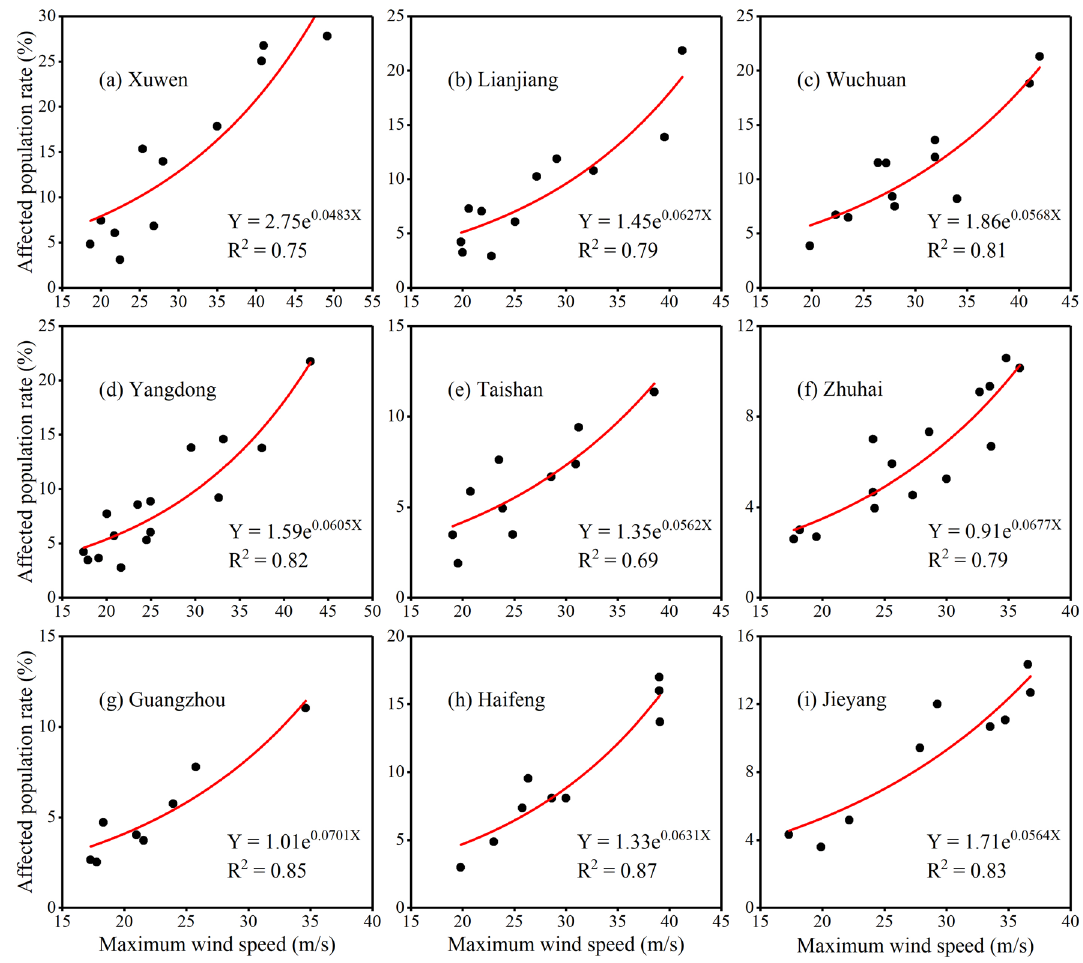
Fig. 3 Loss rates for the affected population fitted with maximum wind speed (MWS) by an exponential function in nine coastal districts from south to north in Guangdong